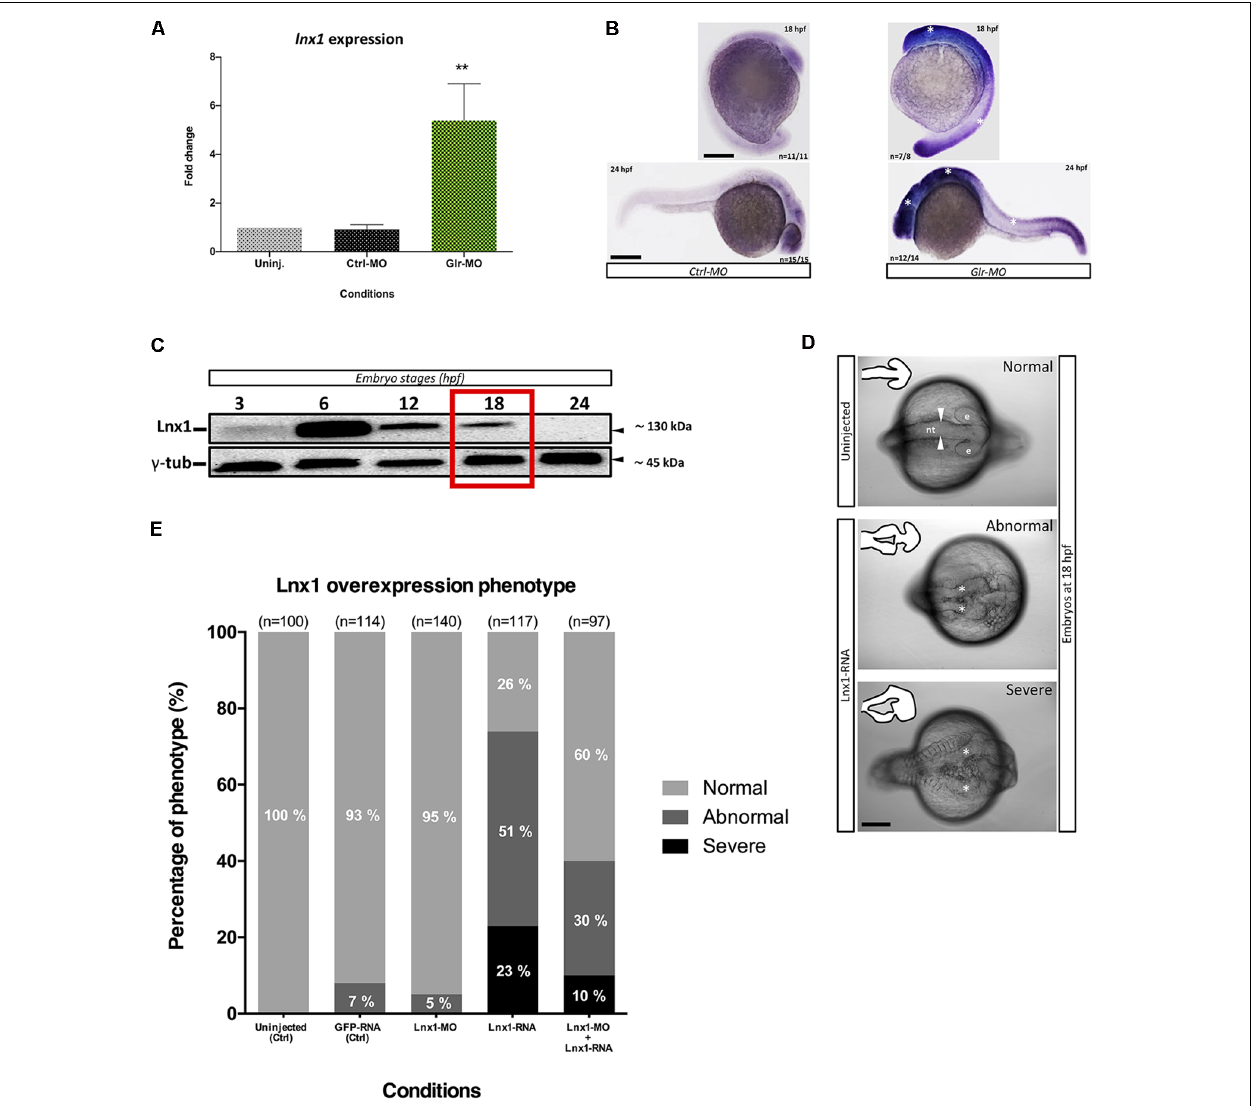
FIGURE 1 | Glycine signaling regulates Ligand of numb protein-x1 (lnx1) expression during neural tube development. (A) Quantification of lnx1 expressions into sorted GFAP + -neural stem cell (NSC) by RT-qPCR revealed a significant up-regulation of lnx1 expression upon glycine signaling disruption compared with uninjected and Ctrl-morpholino (MO) conditions. One-way ANOVA statistical analysis was performed ( n = 3, ∗∗ p -value < 0.01). (B) Whole-mount in situ hybridization at 18 and 24 hours post fertilization (hpf) revealed that disruption of glycine signaling by glycine receptor morpholino (Glr-MO) induces an overexpression of lnx1 into central nervous system (CNS; right) compared with control condition (left; Scale bar, 200 µ m). (C) Time course of transient lnx1 overexpression revealed by Western blot; embryos were injected with lnx1-6myc RNA then in vivo expression of lnx1 protein was detected by anti-myc antibodies and followed during five-time point including, 3, 6, 12, 18 and 24 hpf, and anti- γ -tub antibody was used as loading protein control. (D) Neural tube closes defects upon lnx1 overexpression; embryos were injected with lnx1-6myc RNA, then neural tube was imaged at 18 hpf. Phenotype of neural tube defect closure caused by lnx1 overexpression was divided into three classes: normal neural tube (arrowheads), abnormal neural tube and neural tube with severe defects (asterisks) from top to down respectively. Structure of neural tube was delineated in the corner of each image. (e, eye; nt, neural tube. Scale bar, 250 µ m). (E) Quantification of lnx1 overexpression phenotype in each condition including uninjected, GFP-mRNA, lnx1 -MO, lnx1 -RNA or lnx1 -MO and lnx1 -RNA